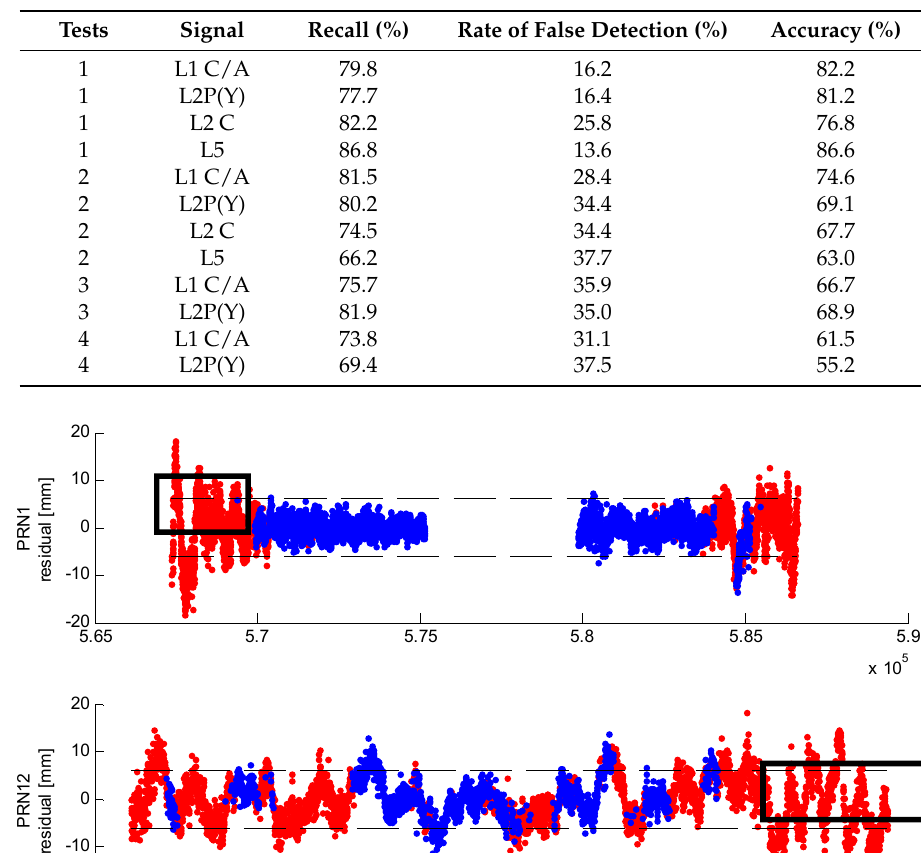
Figure 11. The moving trajectory of antenna and positions of pegs in Dataset KTR2. Tables 10 and 11 show the Root Mean Square (RMS) positioning errors in horizontal and height components and 3D of the positioning solutions using simple elevation model, SIGMA- ε model, and new model based on down-weighting the detected multipath measurements (with Equation (10)). The improvements of percentage are relative to the standard least squares solution (i.e., without a stochastic model). Table 10. RMS errors in horizontal and height components and their percentage improvement (when comparing with the results of other stochastic models) of the tested stochastic models based on the proposed method in Dataset KTE1.